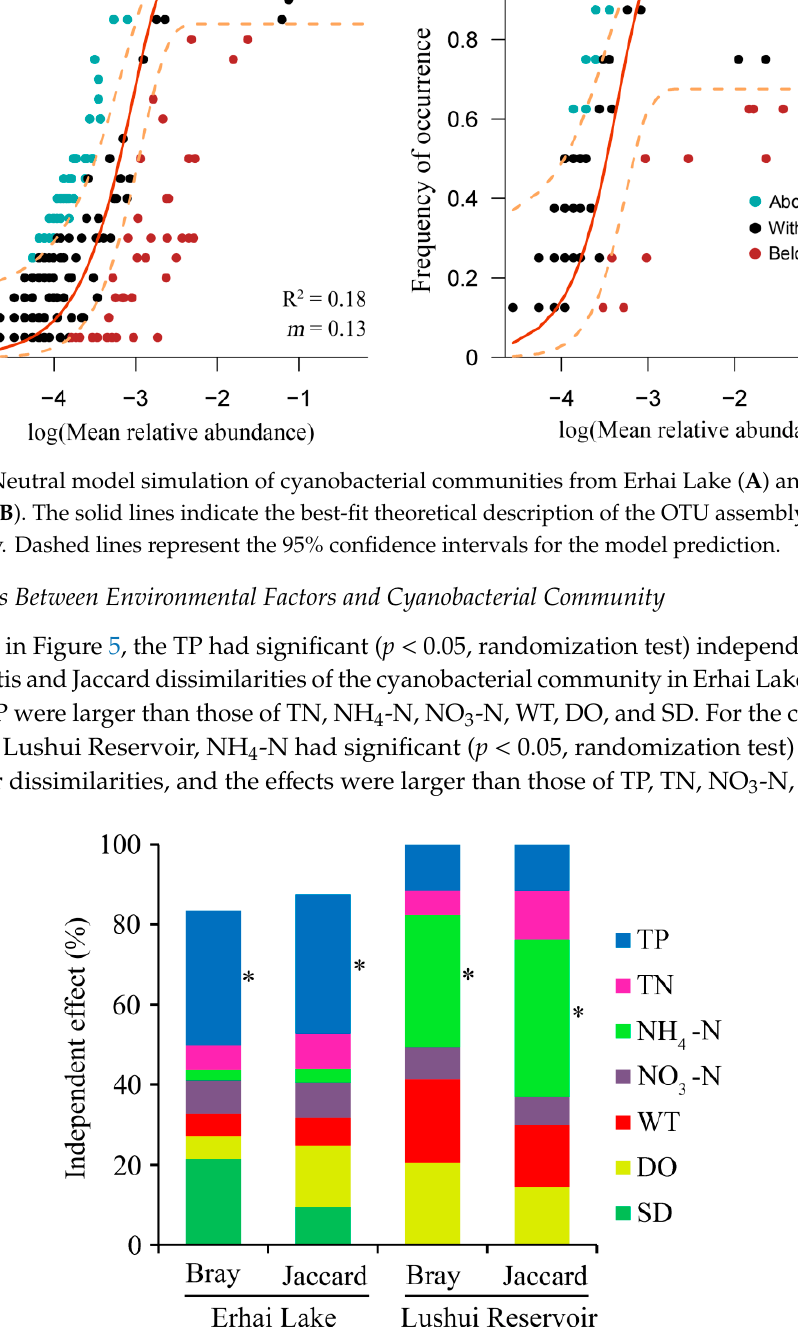
Table 2. Mantel tests for the correlations between environmental factors and cyanobacterial community compositions.